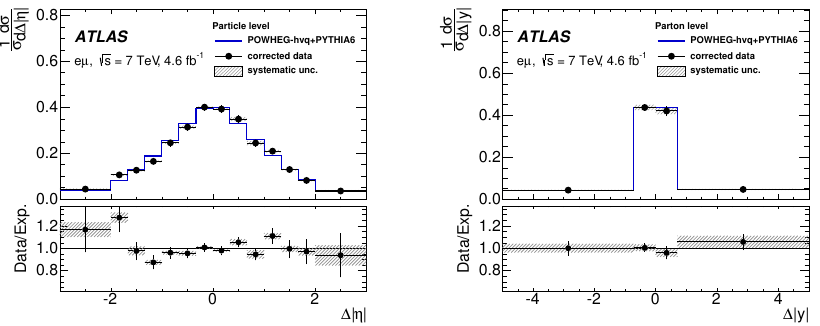
Figure 2. Normalized differential cross-sections for lepton ∆ | η | ( left ) and t ¯ t ∆ | y | ( right ) in the e µ channel after correcting for detector effects. The distributions predicted by POWHEG-hvq + PYTHIA6 are compared to the data in the top panels. The bottom panels show the ratio of the corrected data to the predictions. The error bars correspond to the statistical uncertainties and the hatched area to the systematic uncertainties